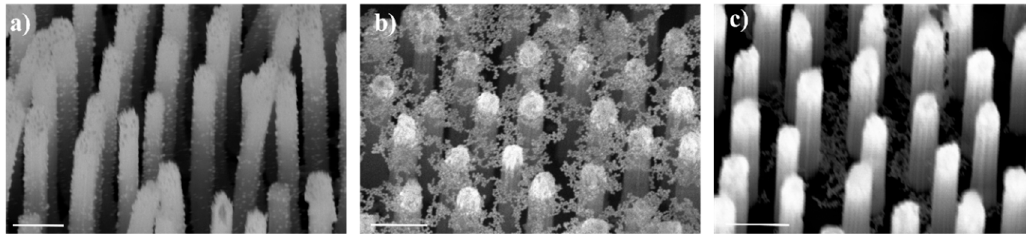
Figure 2. Conjugation of AuNPs on different sites of SiNRs. ( a ) SEM image of synthesized AuNPs; ( b ) B-SiNRs@AuNPs substrate; ( c ) S-SiNRs@AuNPs substrate; ( d ) T-SiNRs@AuNPs substrate.